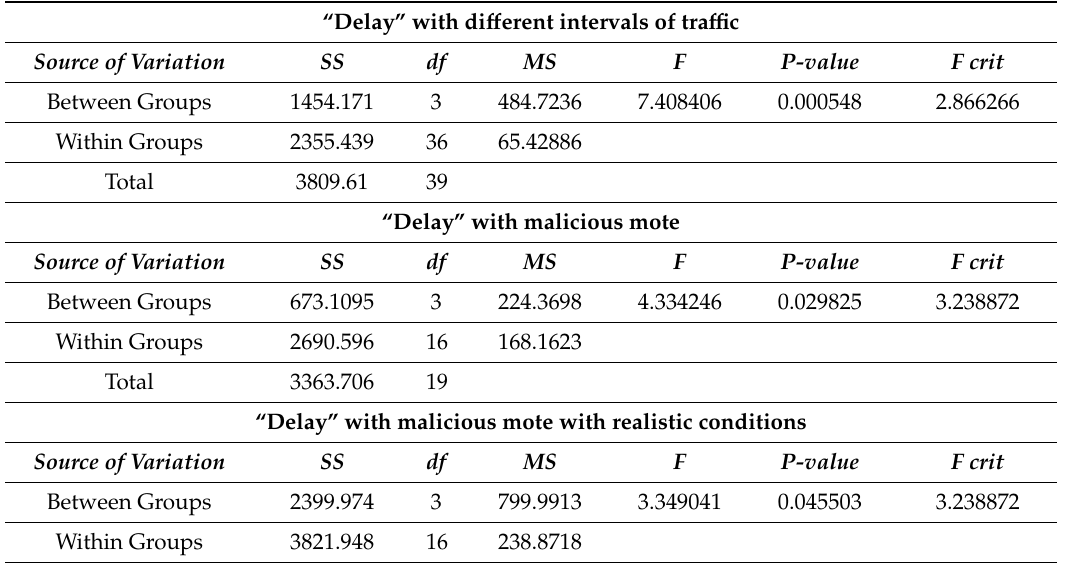
Table 5. ANOVA statistics of the proposed QCM algorithm in terms of “Delay” scenarios.